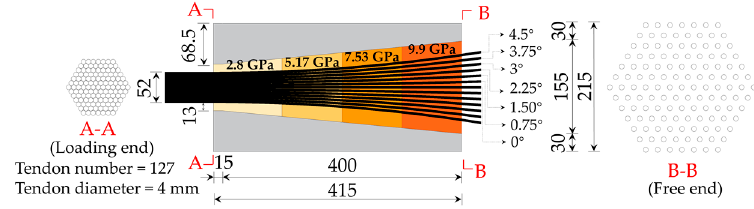
Figure 2. Dispersed-tendon CAS (dimensions in